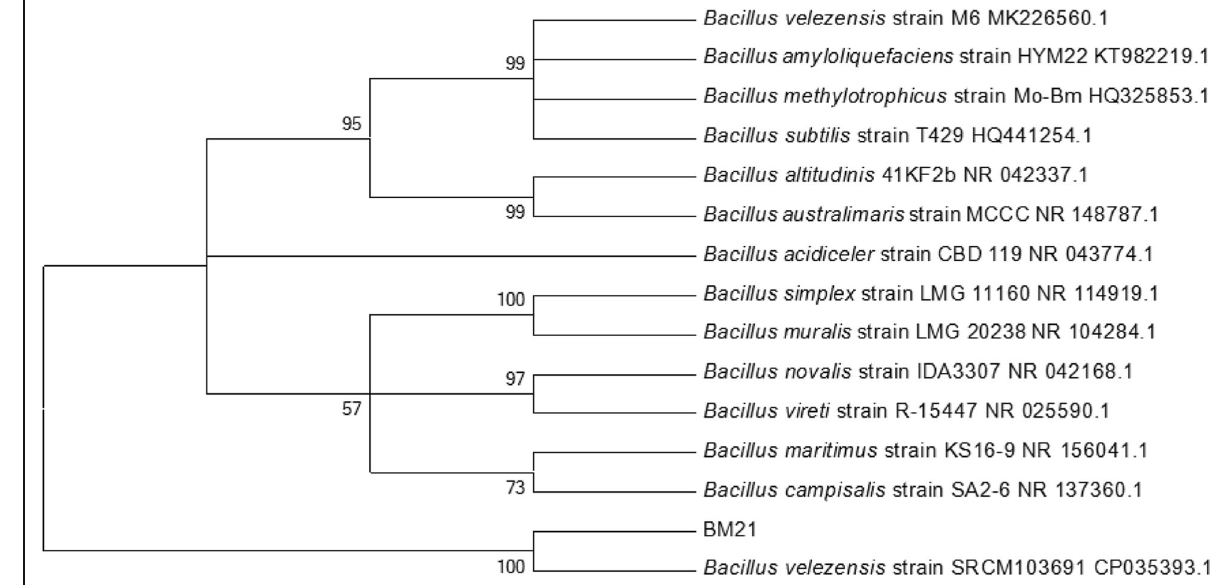
Fig. 1 Phylogenetic analysis to identify bacterial strain BM21 based on 16S rRNA gene